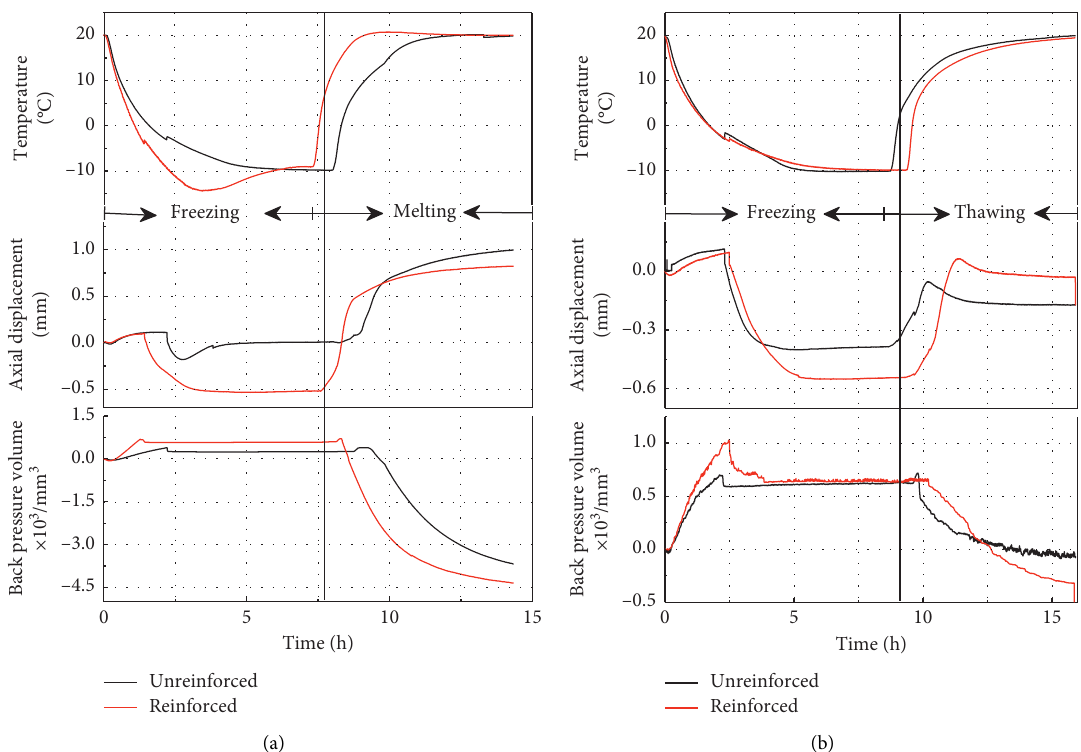
Figure 5: Behavior of expansive soil under different confining pressure in single freeze-thaw ((a) confining pressure of σ confining pressure of σ 3 �